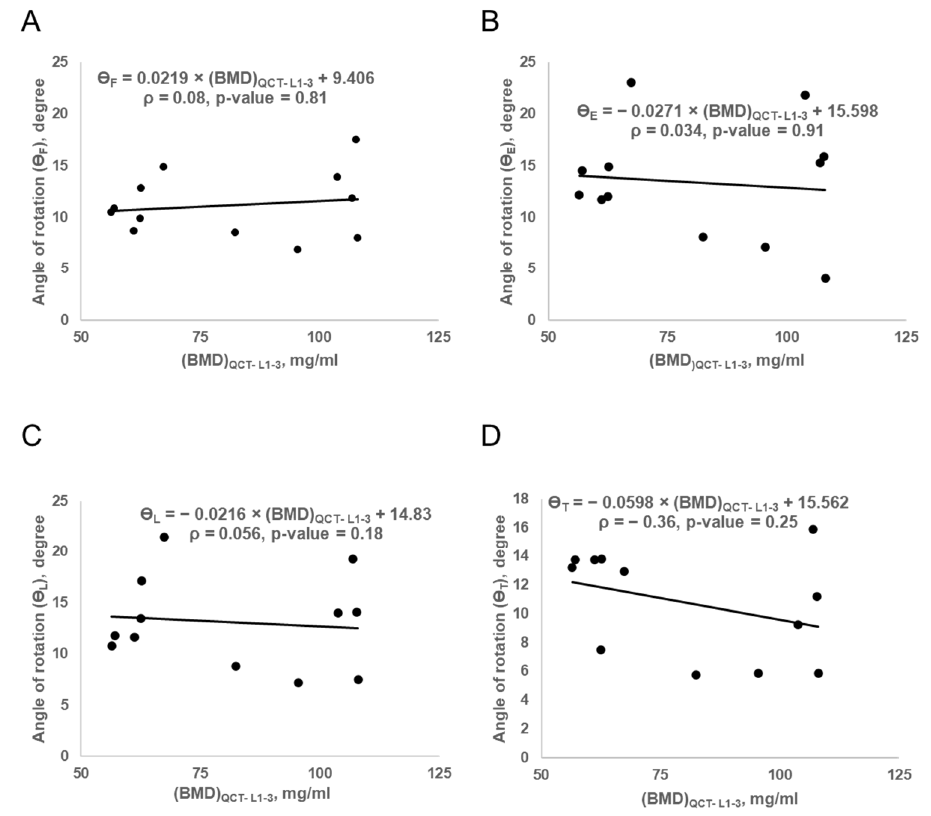
Figure 8. Correlation plot between ROM parameters and QCT BMD: ( A )—flexion angle of rotation ( θ F ) vs. QCT BMD; ( B )—extension angle of rotation ( θ E ) vs. QCT BMD; ( C )—lateral bending angle ( θ L ) vs. QCT BMD; ( D )—twisting angle of rotation ( θ T ) vs. QCT BMD, ρ —Spearman correlation